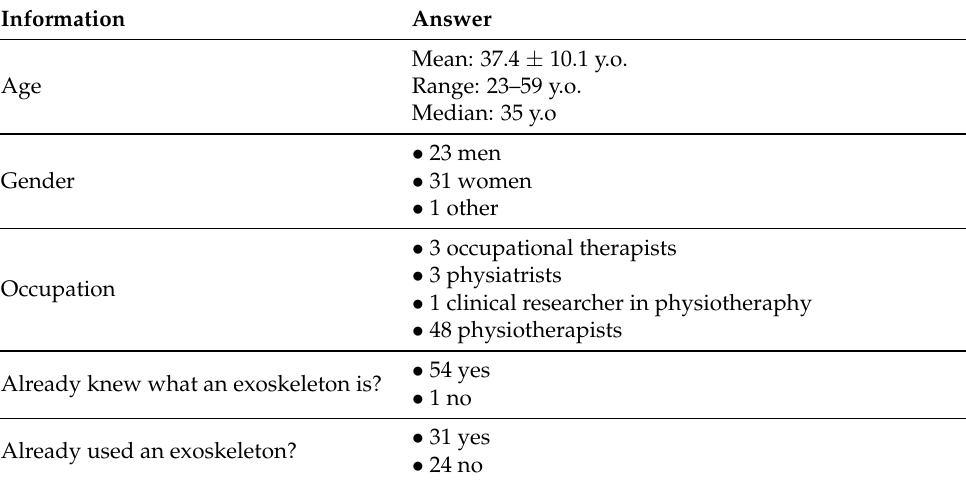
Table 3. Summary of the answers to the general questions.